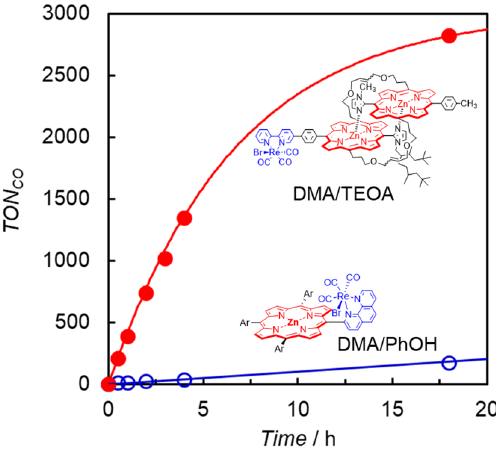
Figure 13. CO formation with time during irradiation at 560 nm from LED lamps for CO 2 -saturated DMA solutions in the presence of BIH, containing either (red filled circle) ReD ′ with TEOA or (blue open circle) ZnP-phen=Re with PhOH.